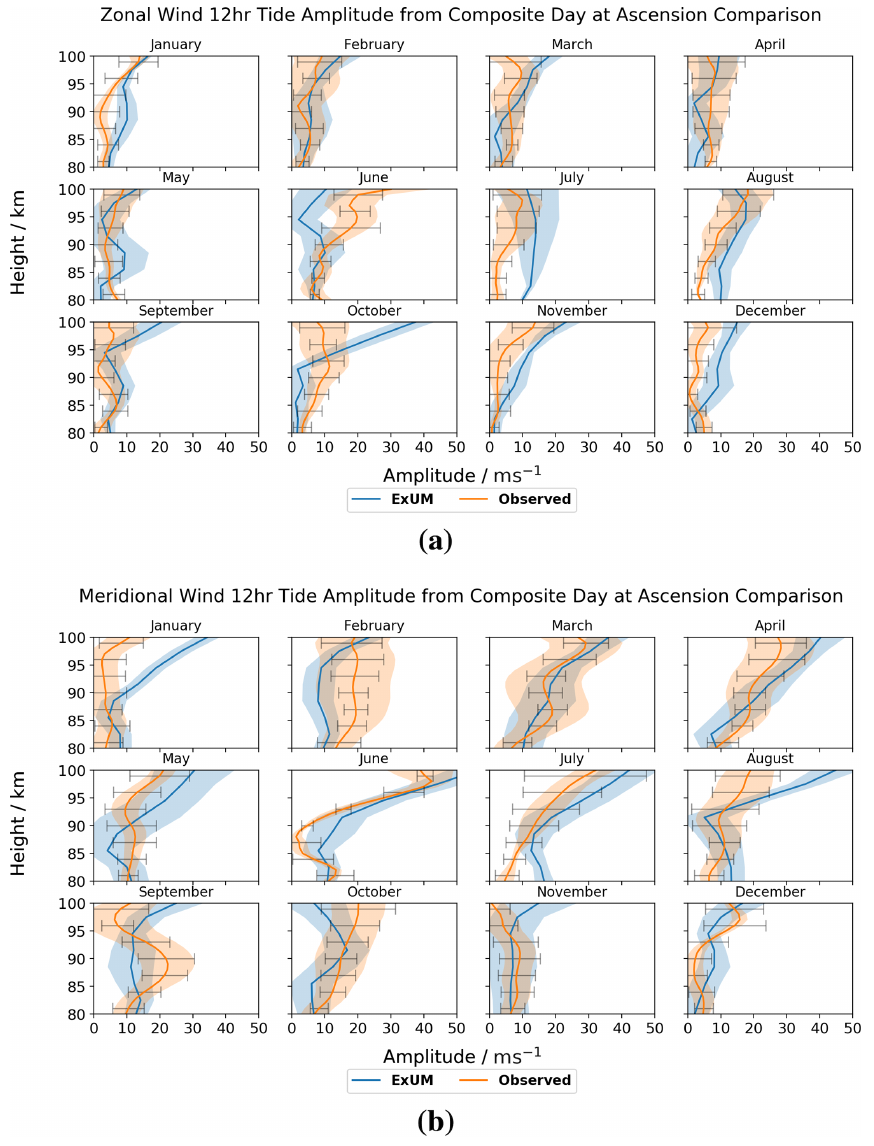
Figure 12. Amplitudes for each month as a function of height for the (a) zonal ( u ) and (b) meridional ( v ) components of the semi-diurnal tide at Ascension Island. The shaded regions denote the standard deviation from the curve-fitting algorithm, and the black bars indicate the standard deviation from the mean of the measured amplitudes across the month. Both the amplitudes from the model (blue) and meteor radar (orange) are